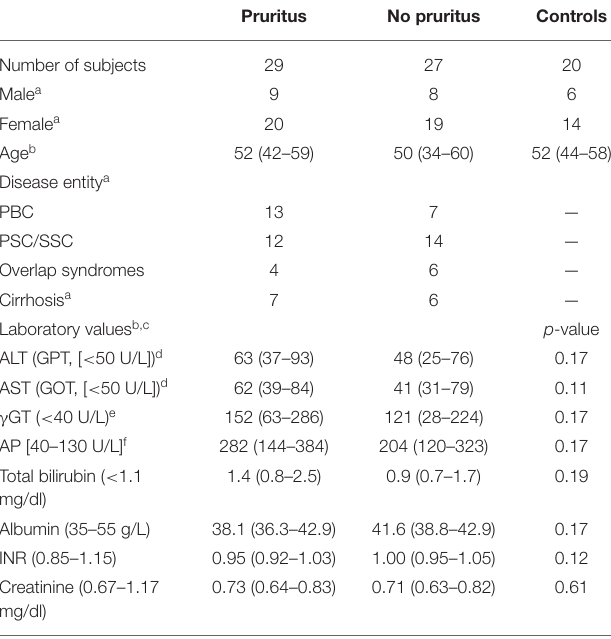
TABLE 2 | Laboratory parameters in 22 patients before and after receiving anti-pruritic treatment with either rifampicin (150–300mg qd) or bezafibrate (400mg